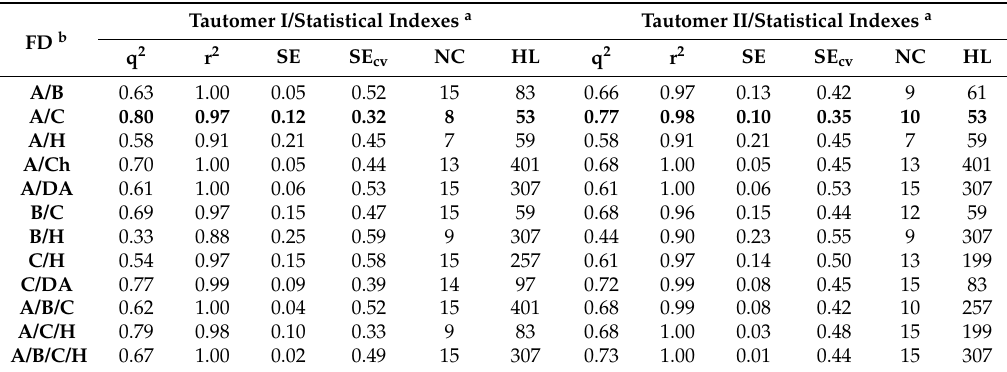
Table 3. Summary of hologram quantitative structure–activity relationship (HQSAR) statistical indexes for various fragment distinction (FD) parameters using the default fragment size (FS = 4–7 atoms) for both tautomers I (amino) and II (imino) data